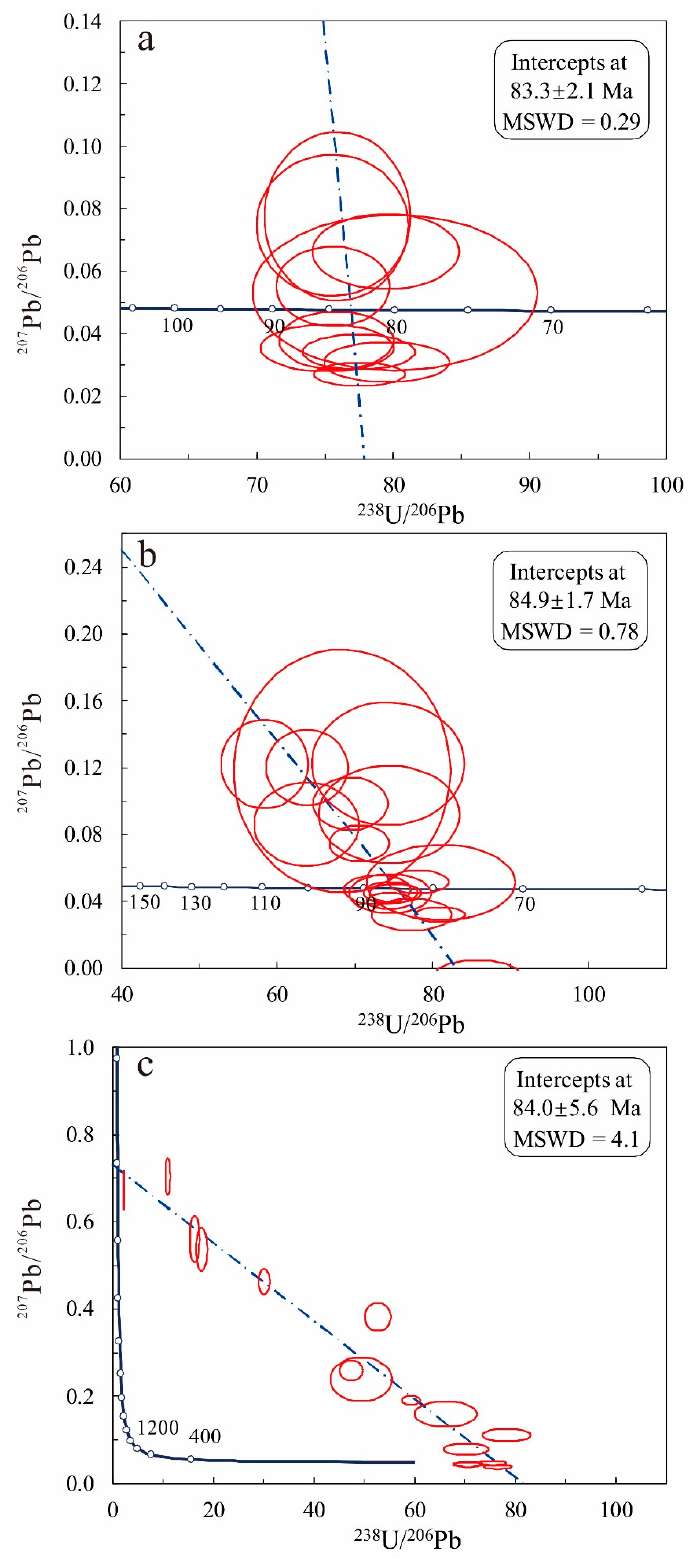
Figure 7. U-Pb Tera-Wasserburg concordia age for cassiterite samples from Xi’ao deposit. ( a ) is the age of XA-3, ( b ) is the age XA-4, ( c ) is the age XA-5.